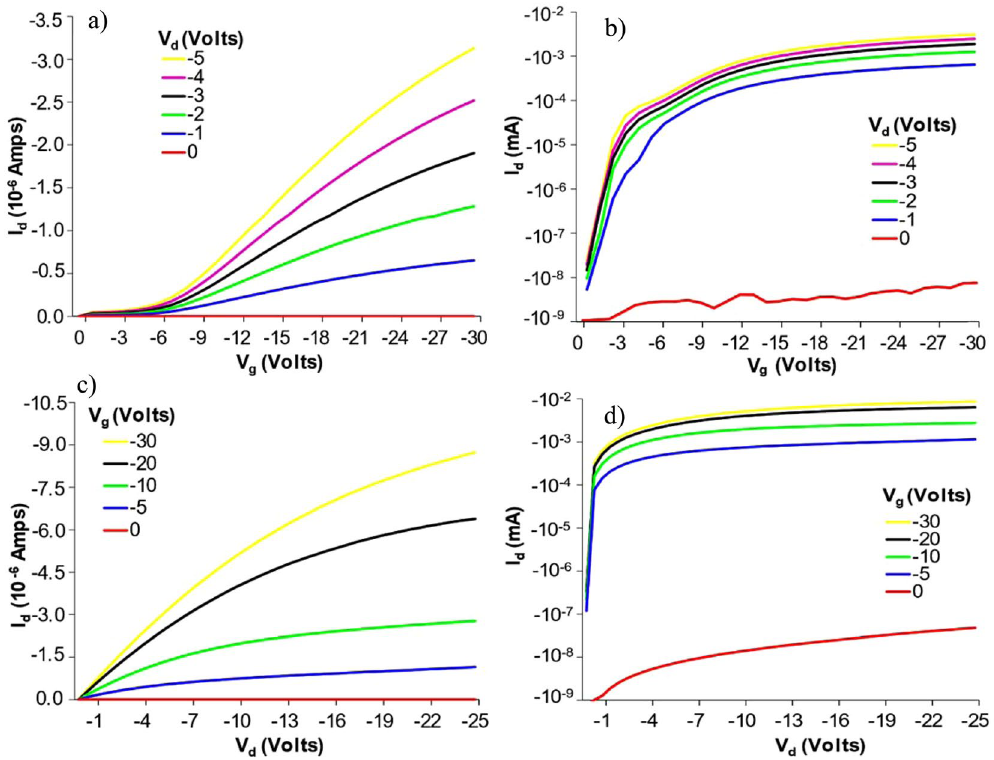
Figure 4. Id vs Vg plotted on a linear ( a ) and logarithmic ( b ) scale. Id vs Vd plot also plotted on a linear ( c ) and logarithmic ( d ) scale. All plots demonstrate the 10 6 on/off